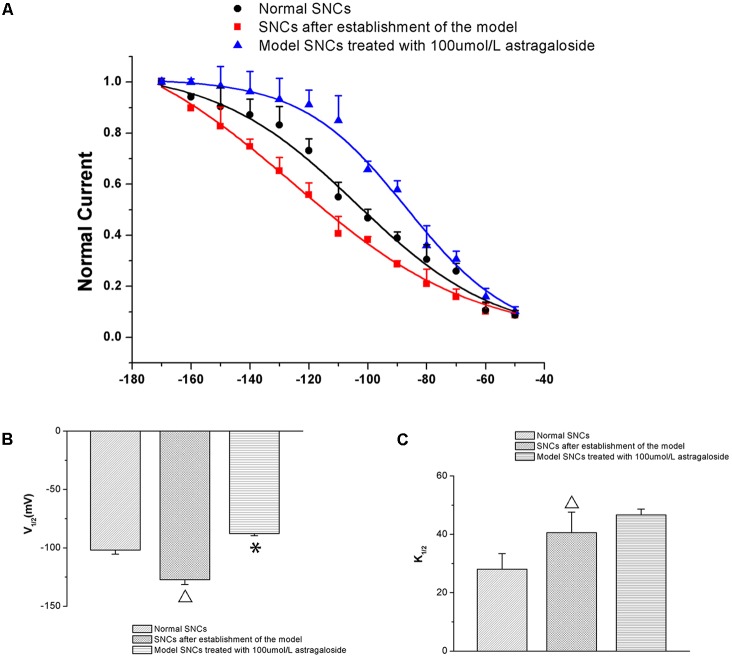
(A) Differences in the SSA curves of the If in each group (n = 10). (B) Effect of astragaloside on the V1/2 of the If in damaged neonatal rabbit SAN cells. ∗P < 0.05 vs. the normal group; P < 0.05 vs. the I/R model group. (C) Effect of astragaloside on the slope factor k of the half activation voltage of the If in damaged SAN cells. ∗P < 0.05 vs. the normal group; P < 0.05 vs. the I/R model group.